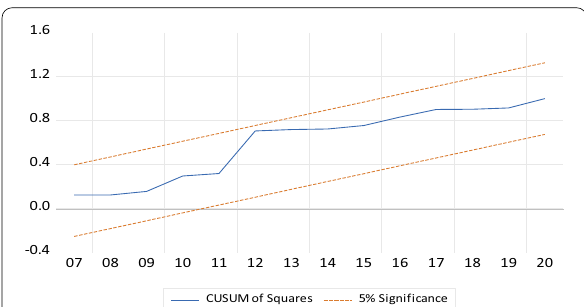
Fig. 2 Cumulative sum of squares of recursive residuals